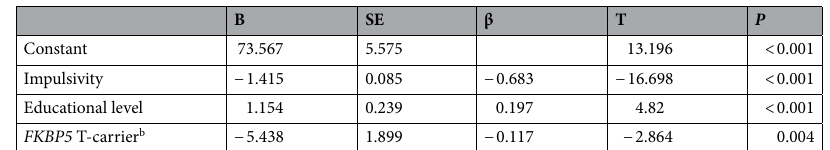
Table 2. Stepwise linear regression analysis a for predicting trait resilience in patients with alcohol use disorder. a Model summary: R 2 = 0.511, adjusted R 2 = 0.506, F = 101.89, P < 0.001. b FKBP5 SNP rs1360780: T allele carrier was coded as 1, CC genotype was coded as